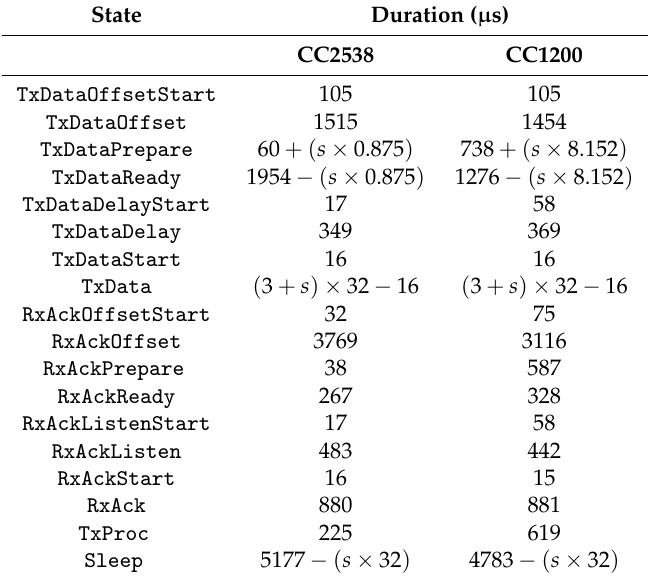
Table 8. State durations in the TxDataRxAck time slot with a total length of 15ms and s being the packet size in bytes.